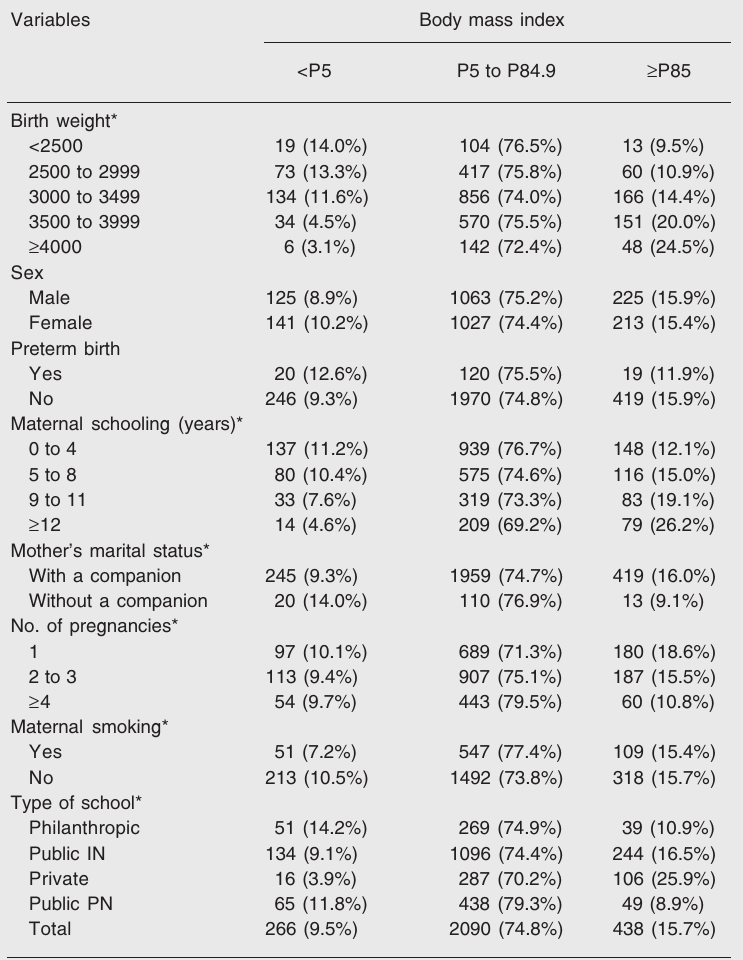
Table 2. Frequency of early life and childhood variables according to body mass index percentile distribution of the schoolchildren.